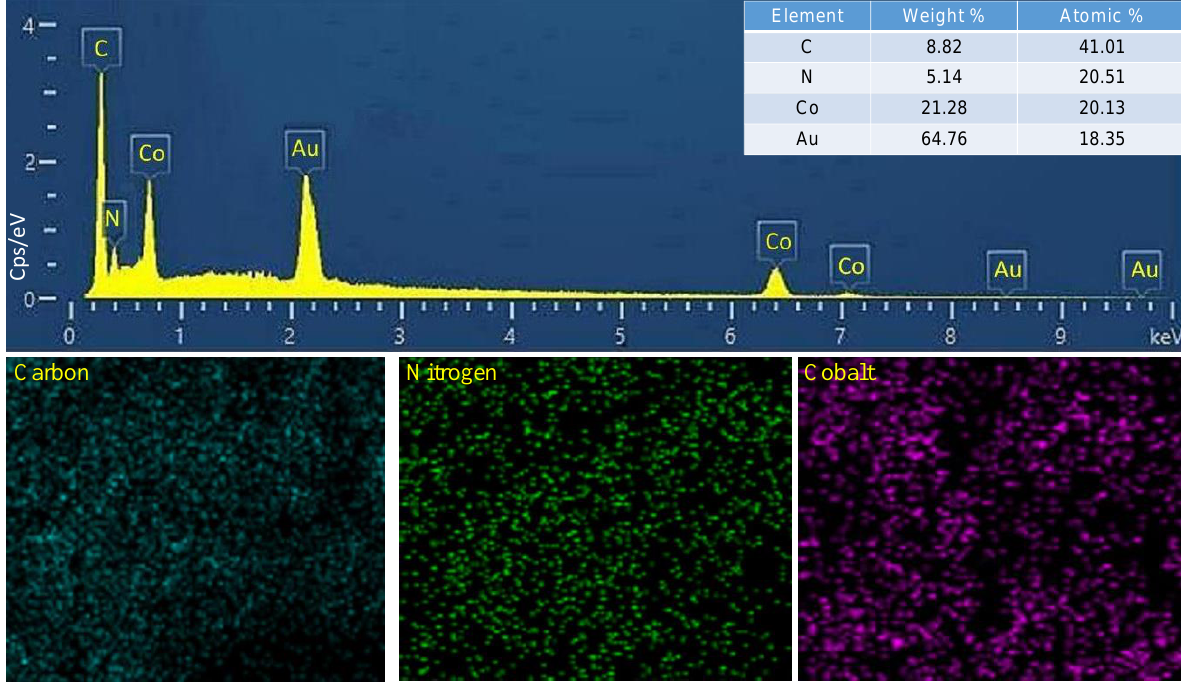
Figure 7. EDS spectra of Co-ZIF catalyst and elemental mapping.